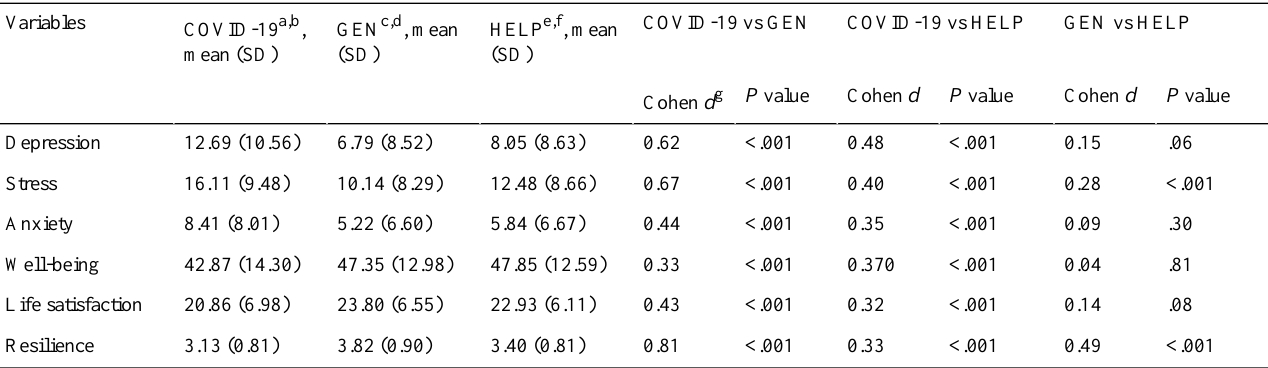
Table 2. Means and SDs for the COVID-19 and control